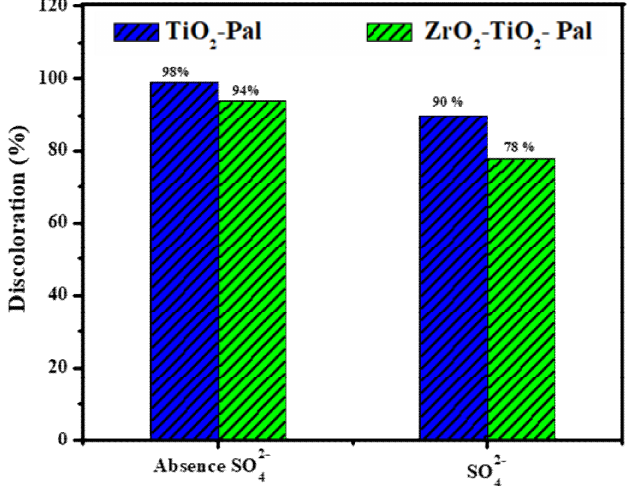
Figure 8. Discoloration percentages of the Remazol Blue using 1.5 g L − 1 photoactive materials in the presence and absence of the sulfate ion under UV light.